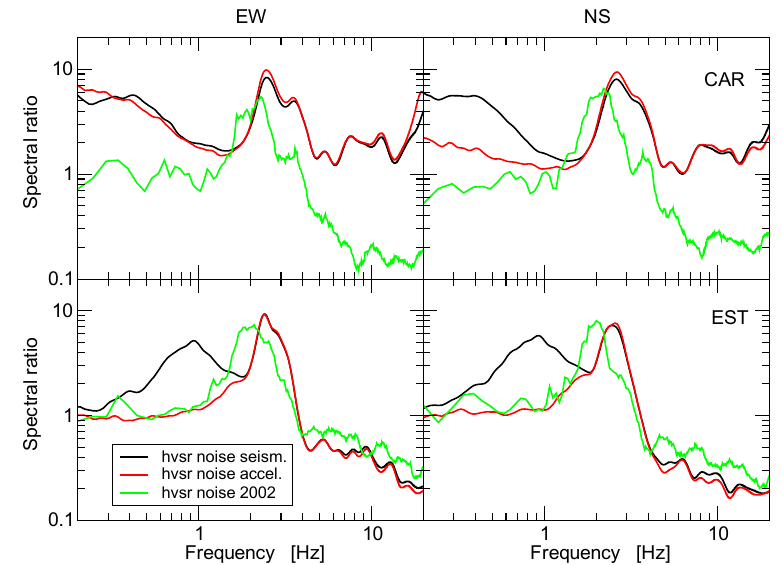
Figure 12. Amplification estimated at sites, CAR and EST, from HVSR computed for ambient noise data. We compare the results using ambient noise recorded using an accelerograph (hvsr noise accel.) and a broad band seismograph (HVSR noise seism.) in August 2017, with the results from measurements made in 2002 (HVSR noise 2002). Results for CAR are compared with 2002 data, recorded at a point 87 m away, to the NE. Results for EST are compared, with a point 582 m away, to the SW.